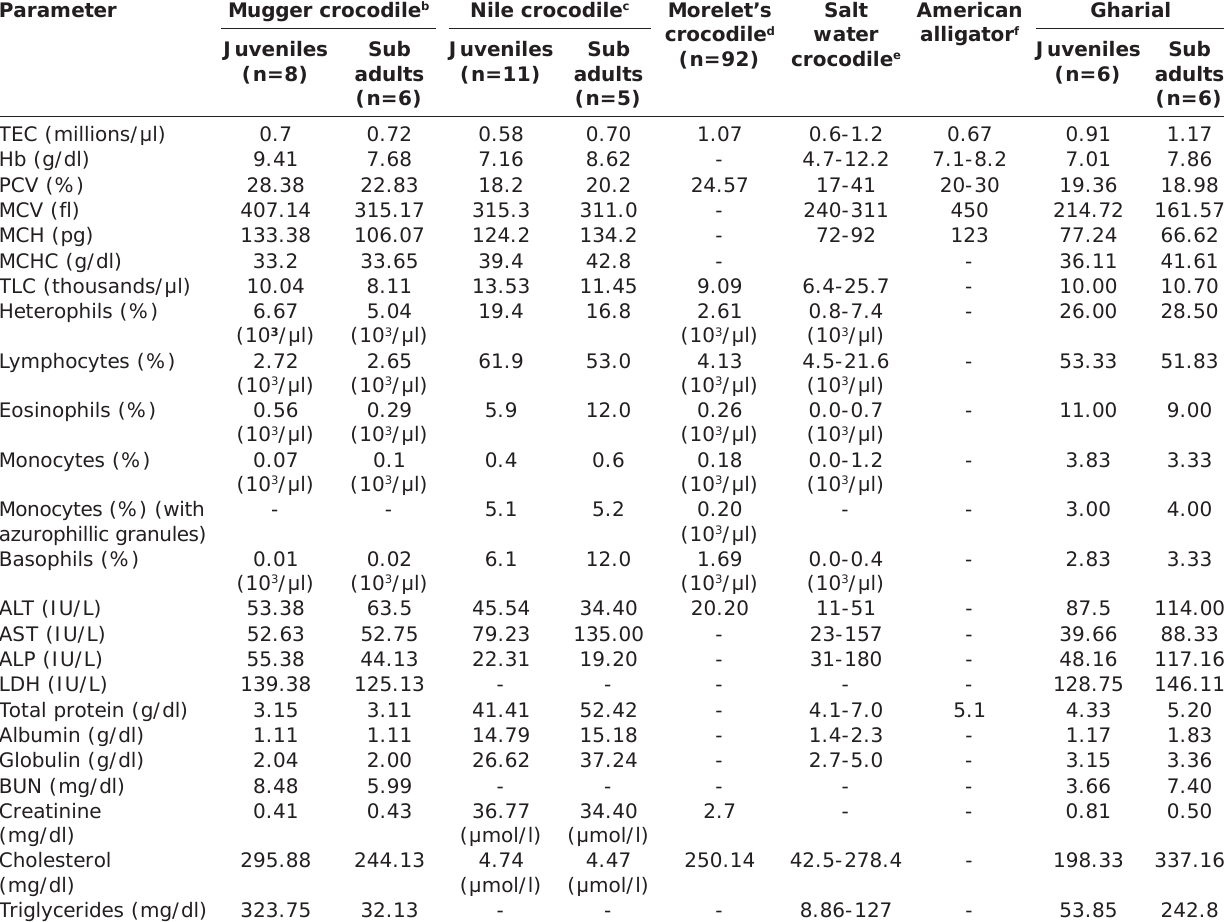
Table-3: Mean reference hematologic and biochemical values for some crocodilians compared with gharials ( G. gangeticus ). a